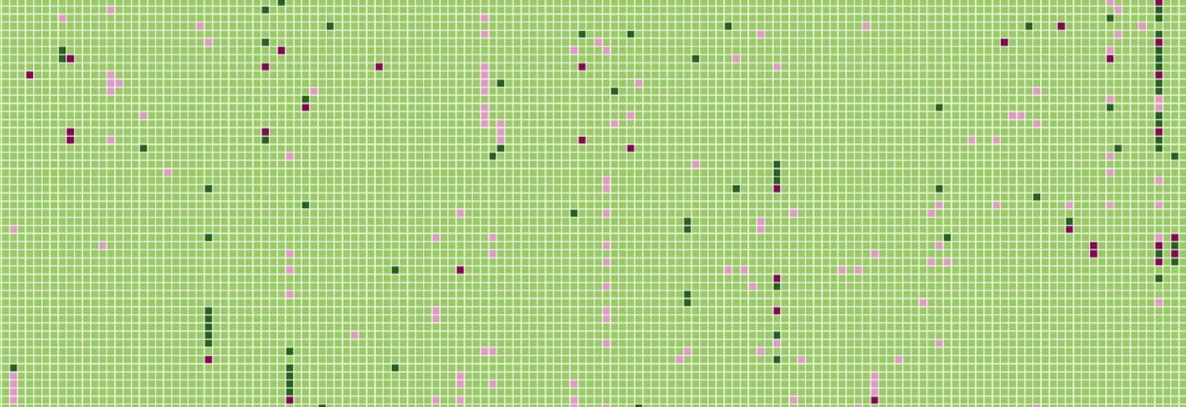
Figure 6. Heatmap representation of the performance with the GCN model for a subset of the compound-odor note associations. The odor notes are represented on the X-axis and the compounds on the Y axis. A compound associated to an odor note and correctly classified by the GCN model is colored with a dark green cell. A compound not associated to an odor note and correctly predicted has a light green color. A compound linked to an odor note and wrongly predicted by the model is represented with a pink color and a compound not linked to an odor note and predicted to be associated to this odor note is shown with a red color. The heatmap was developed with the python package seaborn (v.0.11.2): https:// seabo rn. pydata. org/ 63,64 .